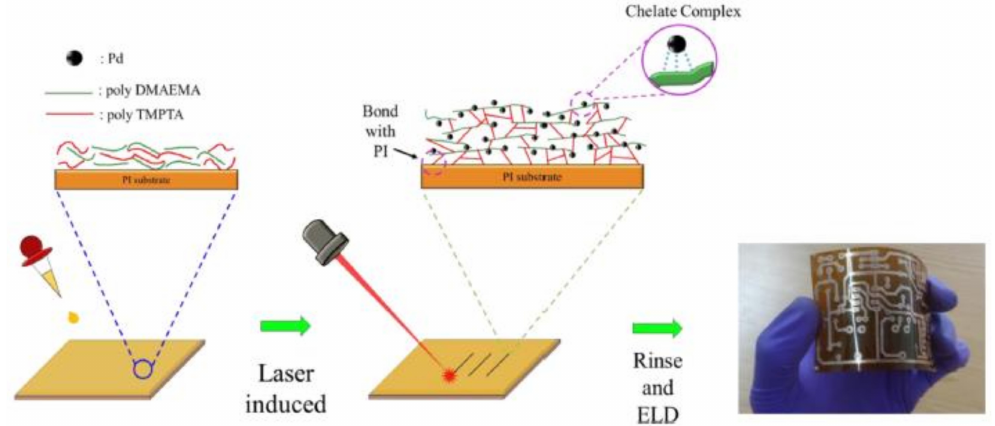
Figure 14. Schematic diagram of the fabrication of Cu-based electronic circuits on PI substrates by thermally curing Pd inks